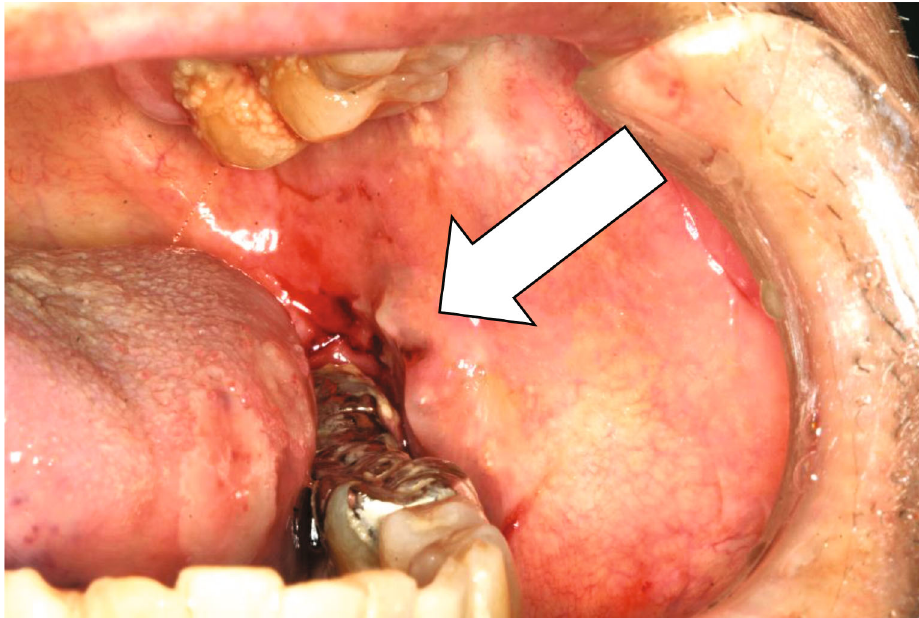
Figure 1: Oral fi ndings in the patient at the initial visit. Ulcers are visible on the left buccal mucosa. Moreover, an erosion is seen on the tongue. Open arrow: cytomegalovirus-associated ulcer.